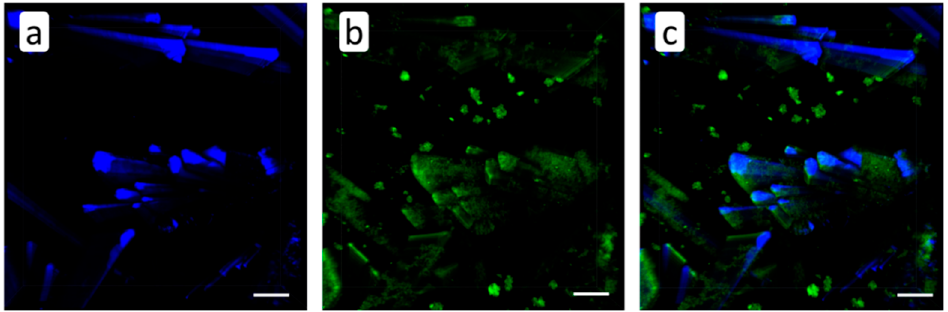
Figure 10. Fluorescent 3D image of the liquid phase of a gypsum solution with 10 mg·dm − 3 PAA-F2/HEDP-F blend (1:1 mass) after 24 h thermal treatment (NACE Standard), obtained by the spectral-resolved fluorescent recording coupled with a linear unmixing of fluorescent signal: a HEDP-F spectral signal (blue, a ); a PAA-F2 spectral signal (green, b ); and a superposition of both channels ( c ). Scale marker corresponds to 50 µm.